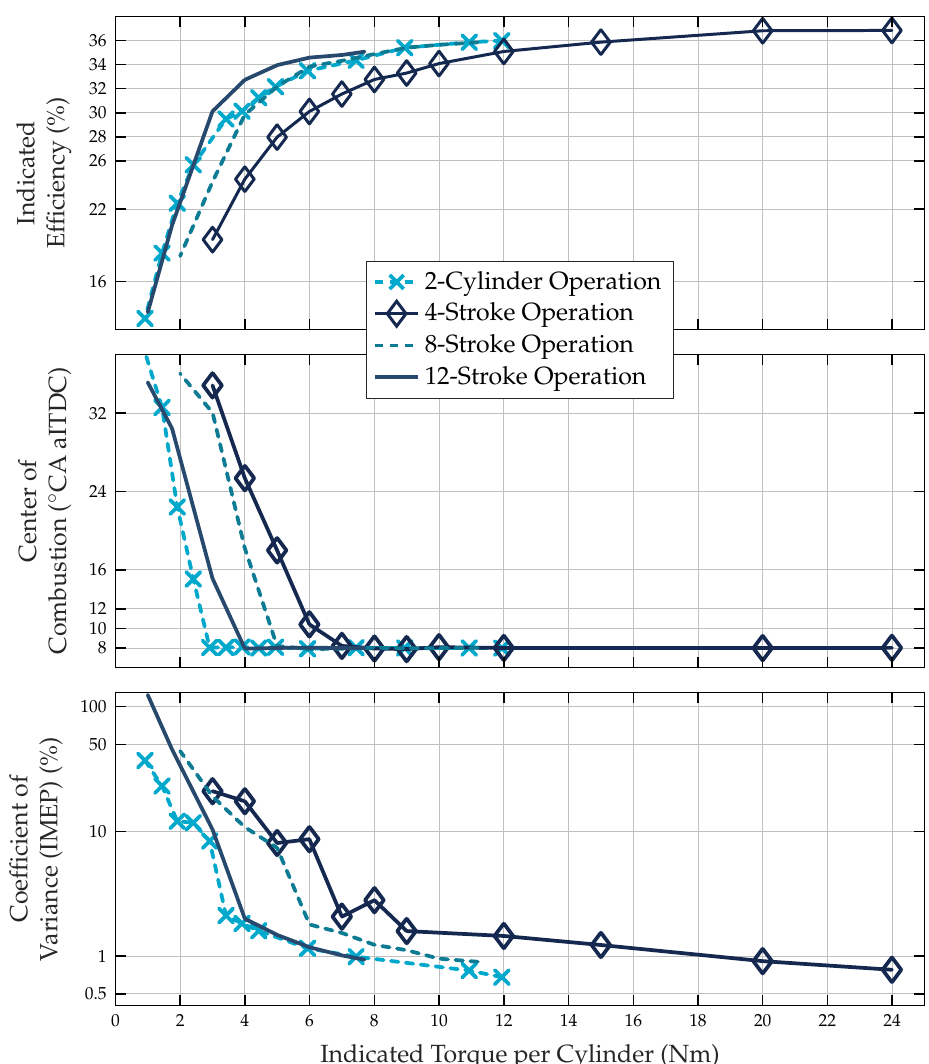
Figure 7. Measured indicated efficiency, the corresponding center of combustion, and IMEP- dependent coefficient of variance, for load variations in 4-, 8-, 12-stroke four-cylinder operations and a four-stroke two-cylinder operation. In the case of the two-cylinder operation, the indicated torque is averaged over all cylinders, firing and